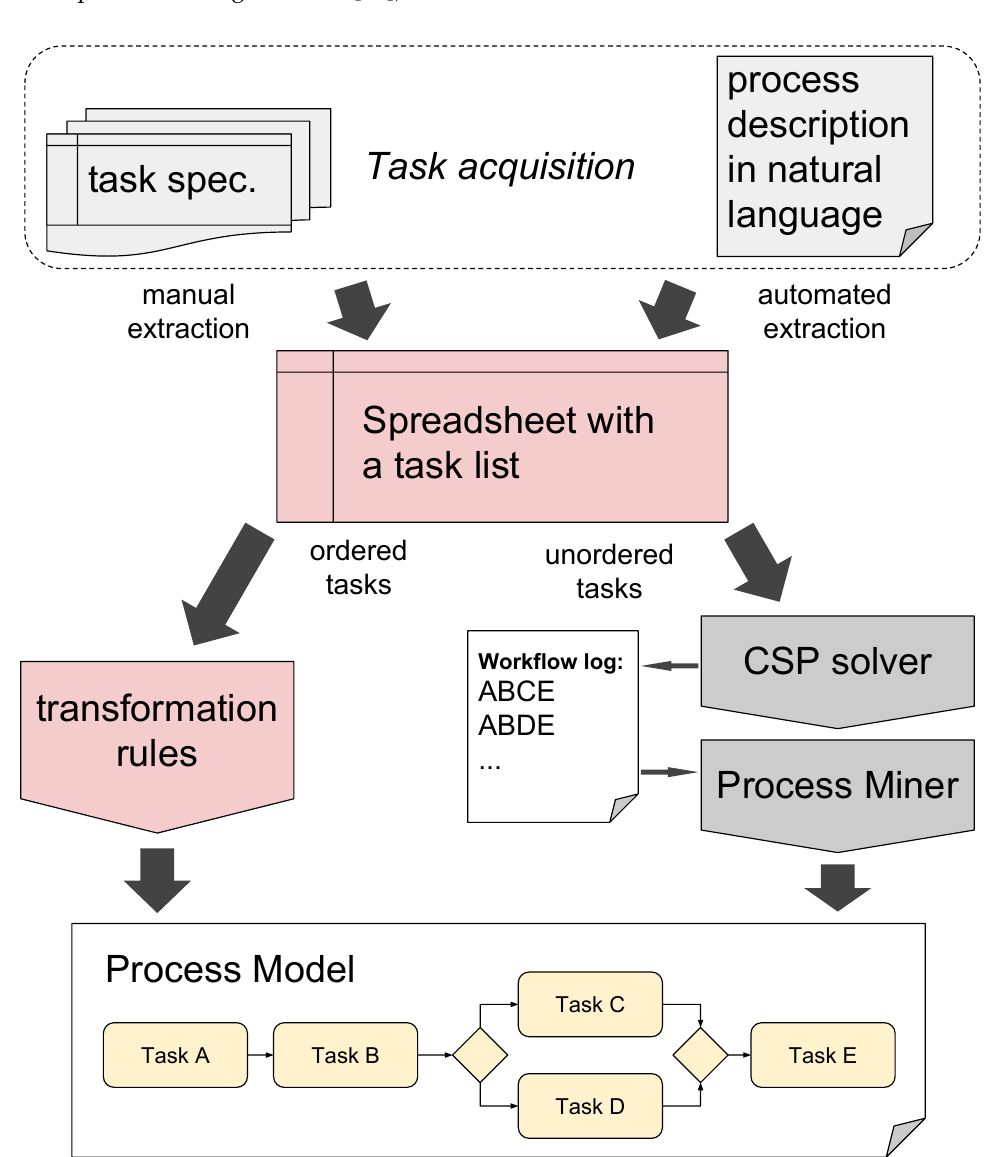
Figure 2. Overview of the spreadsheet-based approach and its place in the context of process